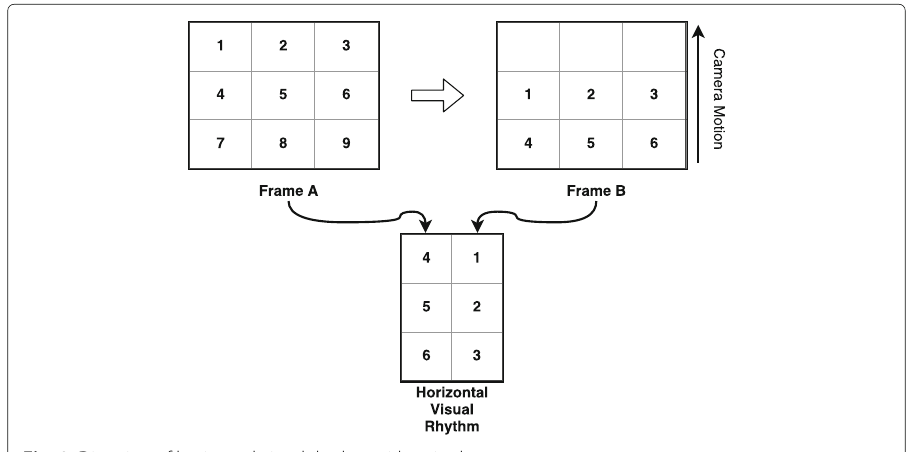
Fig. 8 Direction of horizontal visual rhythm with a single